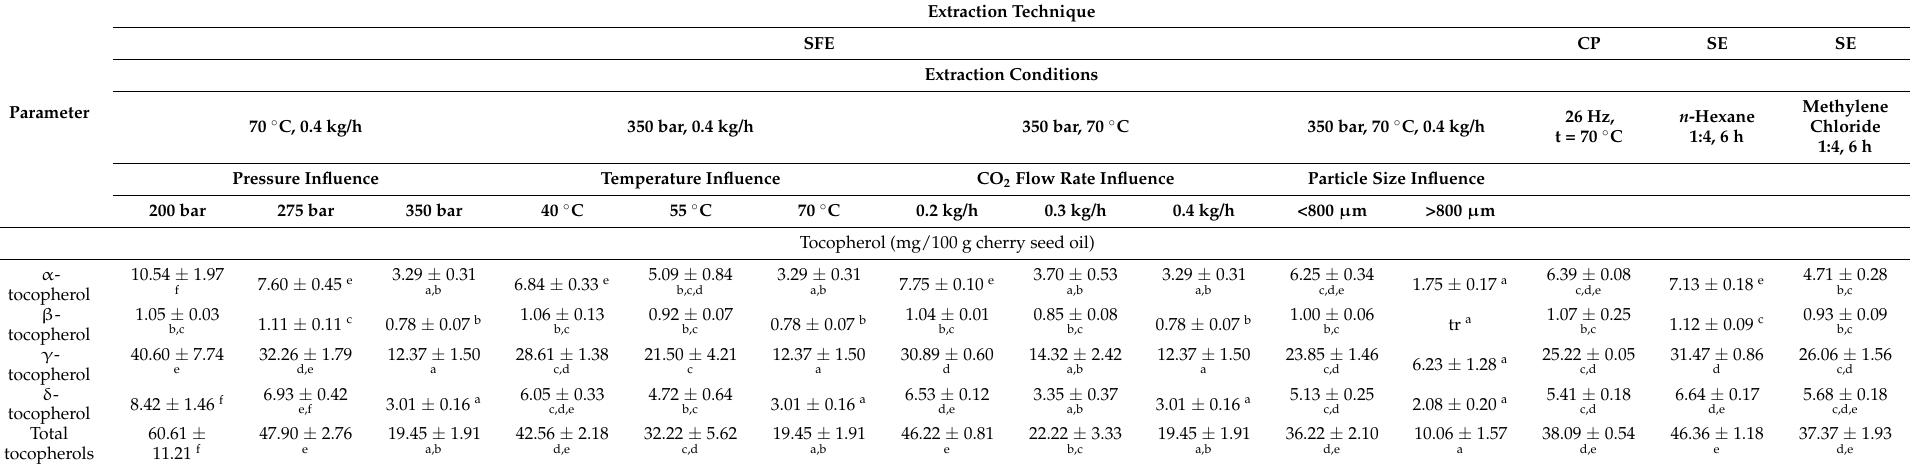
Table 4. Tocopherol yield of cherry seed oils recovered by different extraction